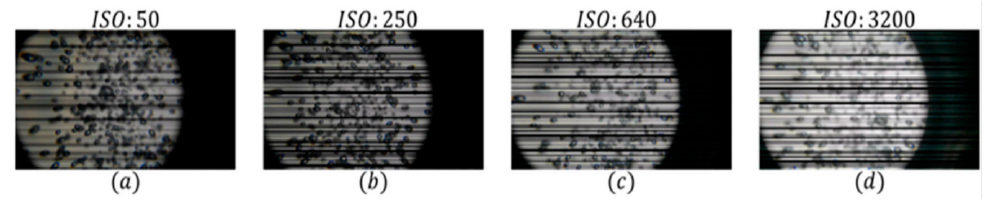
Figure 9. Different imaging conditions in ISOs of ( a ) 50, ( b ) 250, ( c ) 640, and ( d ) 3200.